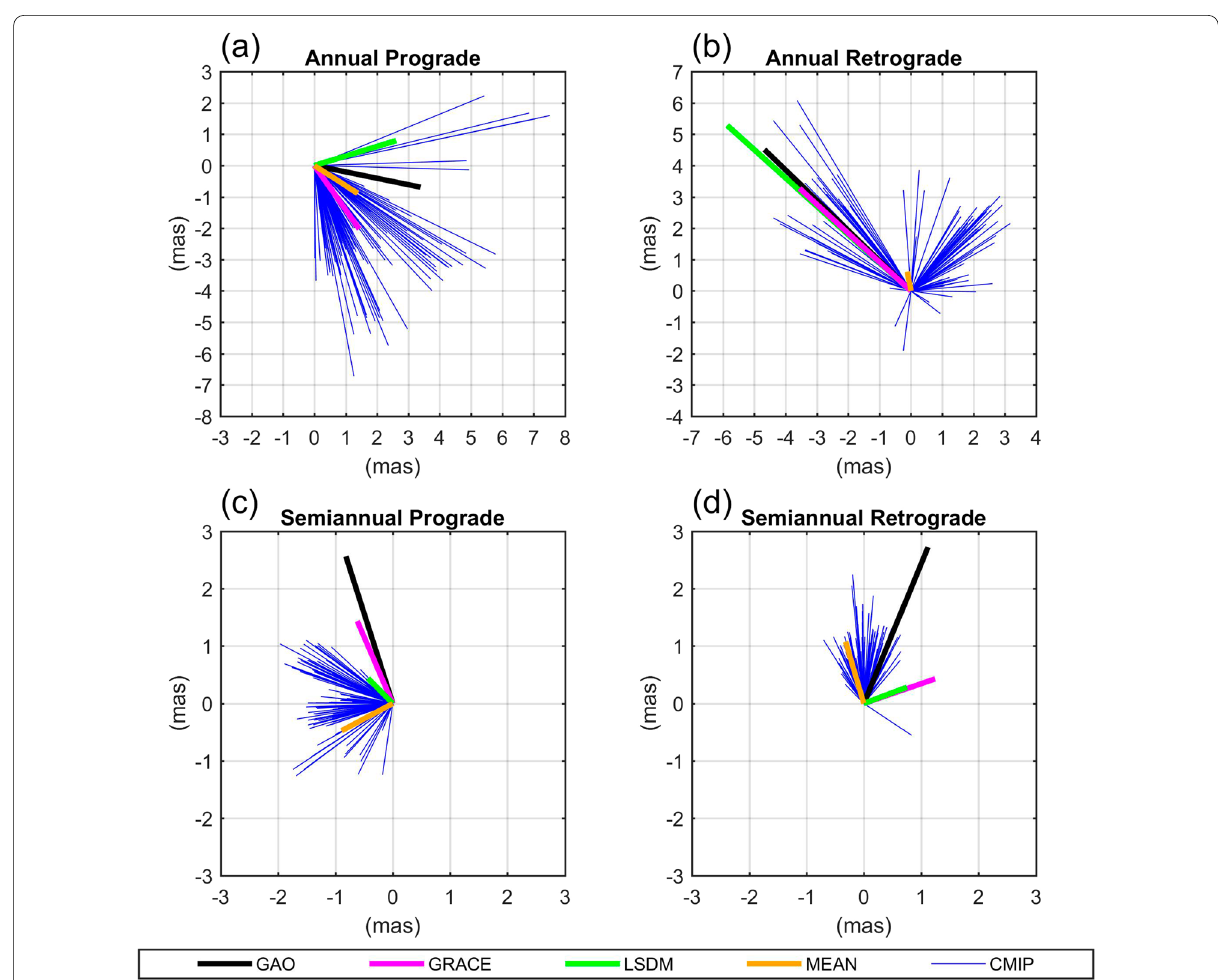
Fig. 5 Phasor diagrams of a annual prograde, b annual retrograde, c semiannual prograde, and d semiannual retrograde oscillation in GAO and HAM computed from GRACE, LSDM, CMIP6 models and MEAN